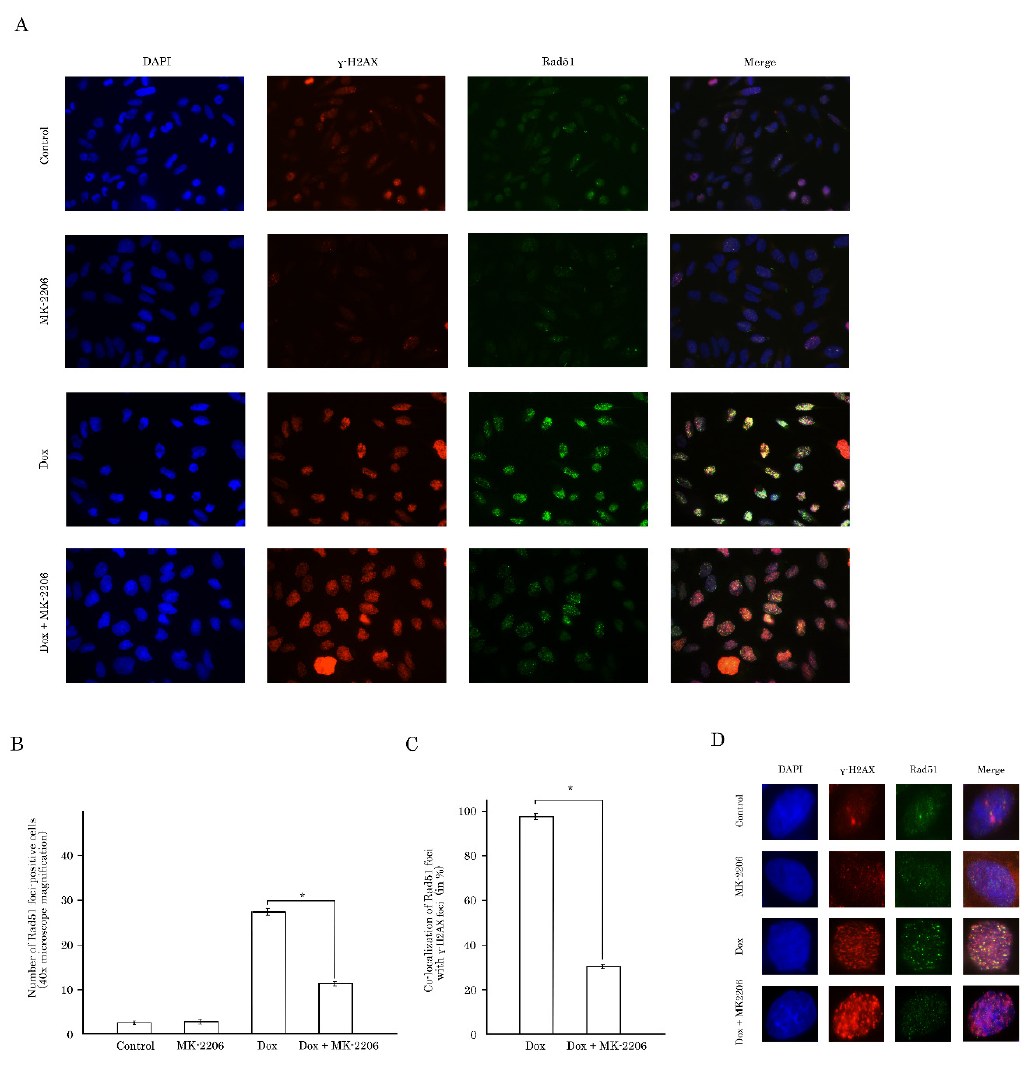
Figure 7. Blockage of Akt signaling pathway disrupts involvement of the Rad51 protein in the repair of DNA DSBs in GIST T-1R cells. ( A ) immunofluorescence staining of GIST T-1R cells for γ -H2AX and Rad51. The cells were cultured in the presence of DMSO (control), MK-2206 (5 µ M for 48 h), Dox (0.25 µ g / mL for 4 h) or pretreated with MK-2206 (5 µ M) for 48 h prior Dox treatment. DAPI staining (blue) was used to outline the nucleus. Scale bars = 20 µ m. ( B ) graph depicting the number of GIST T-1R cells positive for Rad51 foci after Dox treatment alone or in presence of MK-2206 from three independent experiments. Cells treated with DMSO (control) and MK-2206 were used as the negative controls. * p < 0.05. ( C ) graph showing co-localization of Rad51 foci with γ -H2AX foci in GIST T1-R cells after Dox treatment alone or in presence of MK-2206 from three independent experiments. * p < 0.05. ( D ) distribution of γ -H2AX and Rad51 foci in the nucleus in a single-cell level. GIST T-1R cells were pretreated with DMSO (control) or MK-2206 (5 µ M) for 48 h prior Dox treatment (0.25 µ g / mL for four hours). DAPI staining (blue) was used to outline the nucleus. Scale bars = 10 µ